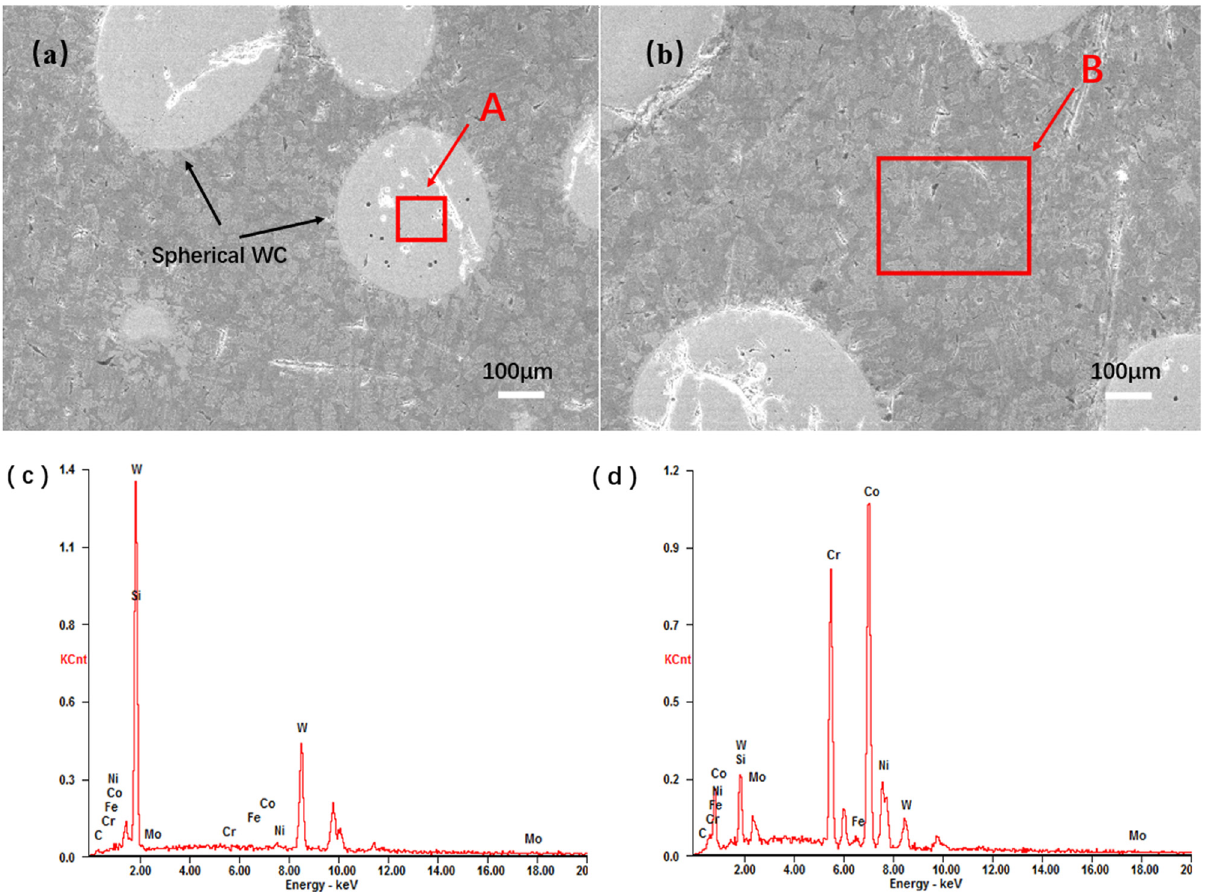
Figure 5: Microstructure of the Co + 60% WC PTA coating. ( a ) Spherical WC; ( b ) Co - based coating; ( c ) EDS spectrum of region A marked in ( a ) ; ( d ) EDS spectrum of region B marked in ( b ) .